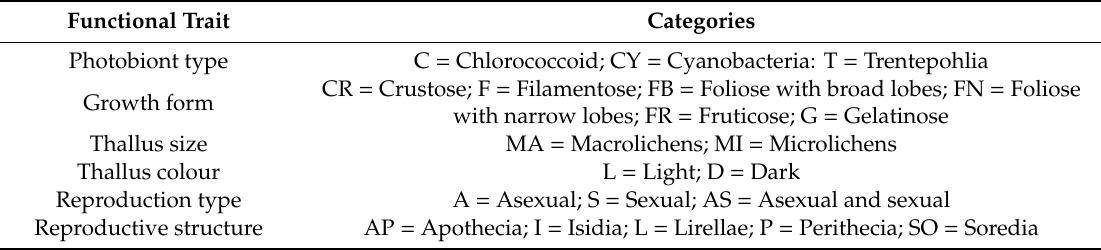
Table 1. List of the six functional traits and their categories of the epiphytic lichen community in four riparian land uses of Andean streams in southern